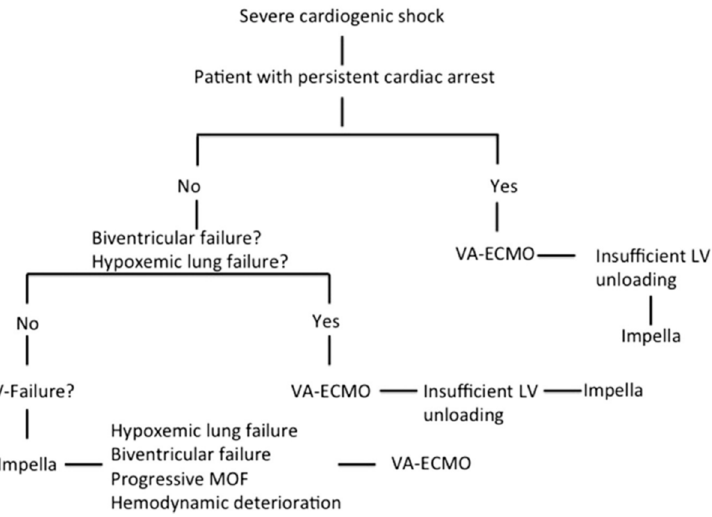
Figure 1. Decision algorithm on mechanical circulatory support in severe cardiogenic shock [19]. (Reproduced with permission from Elsevier).